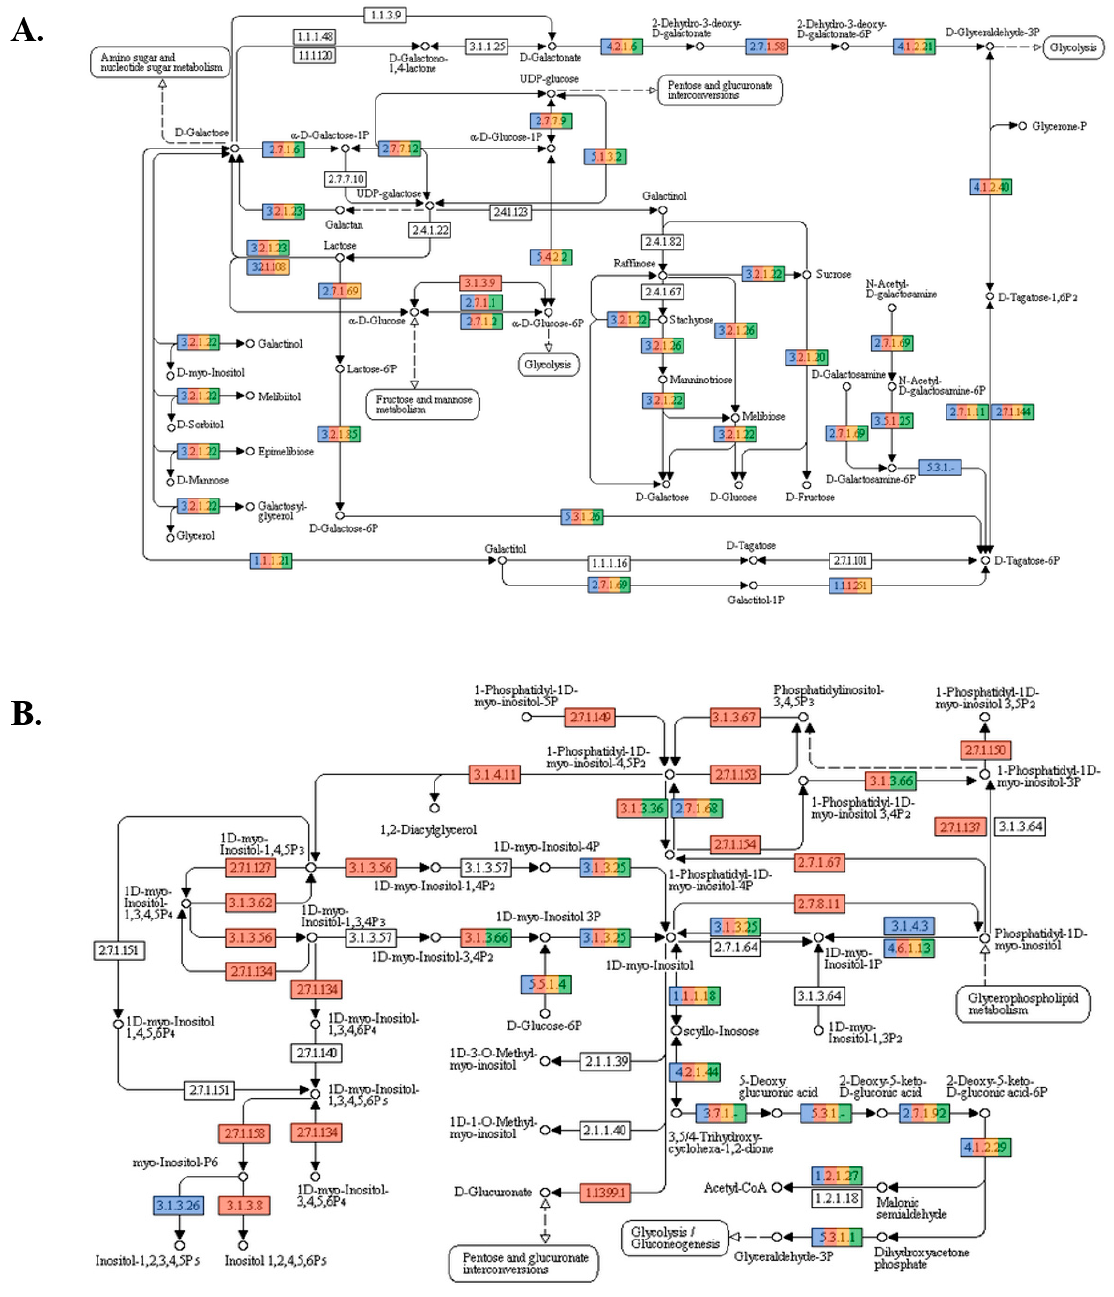
Figure 4. Metabolic pathways obtained from the KEGG mapper for: ( A ) Galactose metabolism and ( B ) Inositol phosphate metabolism. The color code indicates, respectively—yellow for control, red for the prebiotic, blue for the probiotic, and green for the synbiotic.